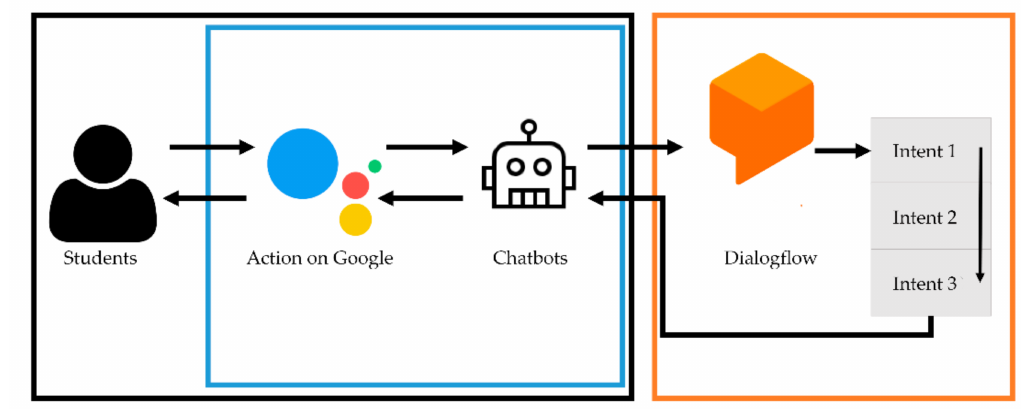
Figure 1. Architecture of the proposed